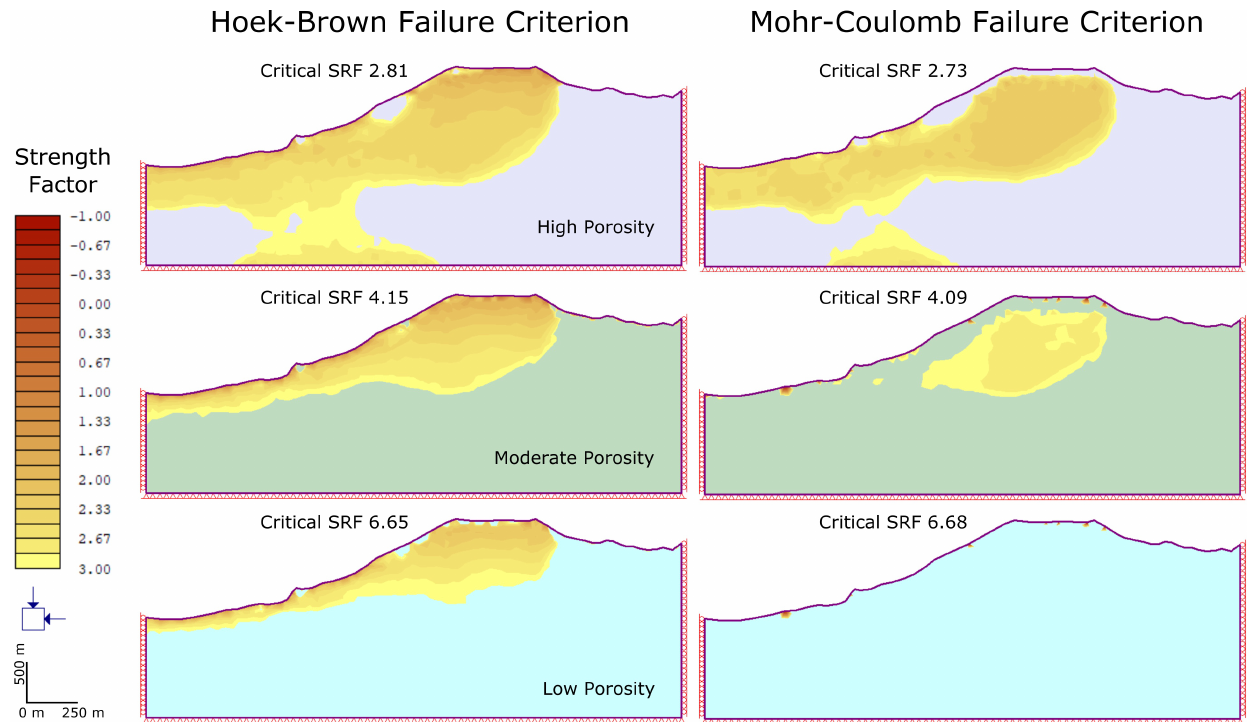
Figure 7: Two-dimensional finite element modelling results of slope stability for low, moderate, and high porosity volcanic rocks with a Geological Strength Index (GSI) of 55 and density of 2650 kg m − 3 , calculated using the m values from Table 2, using generalised Hoek-Brown failure criterion and Mohr-Coulomb failure criterion derived for a slope height of 250 m. The blue stress block in the lower left shows that vertical and horizontal gravita- tional stresses are equal. Only strength factors ≤ 3 are displayed to highlight differences between the modelling